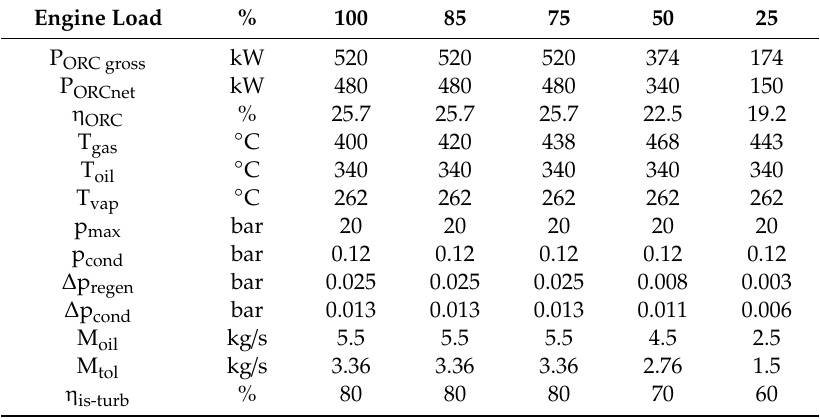
Table 5. Main characteristics for the regenerated ORC cycle in o ff -design